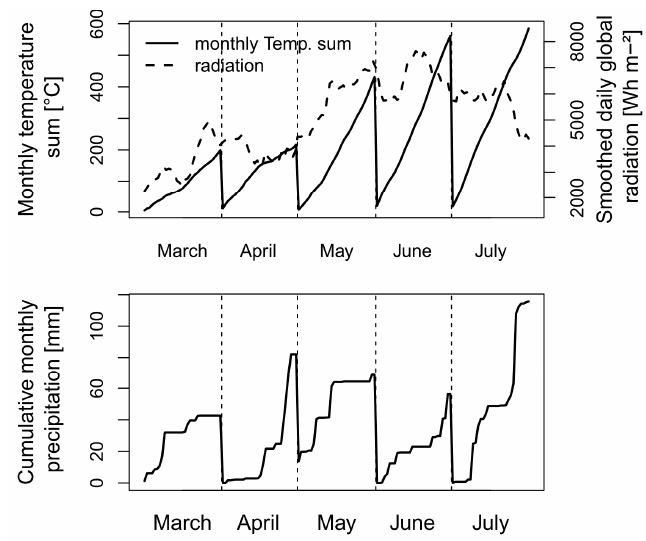
Figure 1. Weather conditions during the main wheat-growing period from March to July 2017 at the experimental site. On 9–10 June, anthesis was on average in the control and reduced fungicide plots and on 6–7 June in the earlier sown plots.